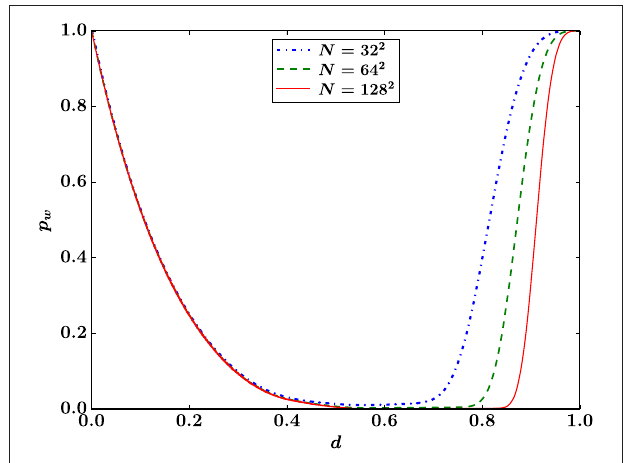
FIGURE 3 | Sample averaged load sharing factor h σ/ f i i for LLS with i = w and i being the broken fiber, and for ELS (Equation 5). The threshold distribution is uniform ( P ( t ) = t ) and the LLS results are from simulations on a square lattice ( N = 128 2 ) averaged over 10 5 samples.